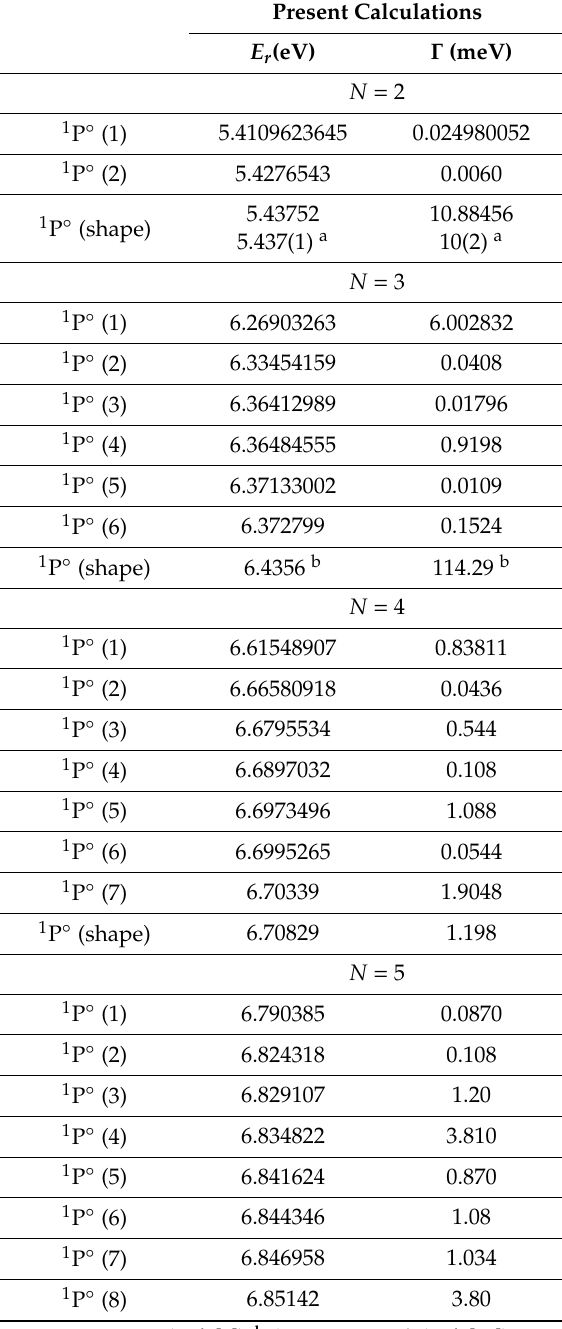
Table 2. The 1 P ◦ Feshbach and shape RP (in eV) in Ps − associated with the N = 2, 3, 4, 5 Ps thresholds. The resonance positions are measured from the ground state of the Ps −